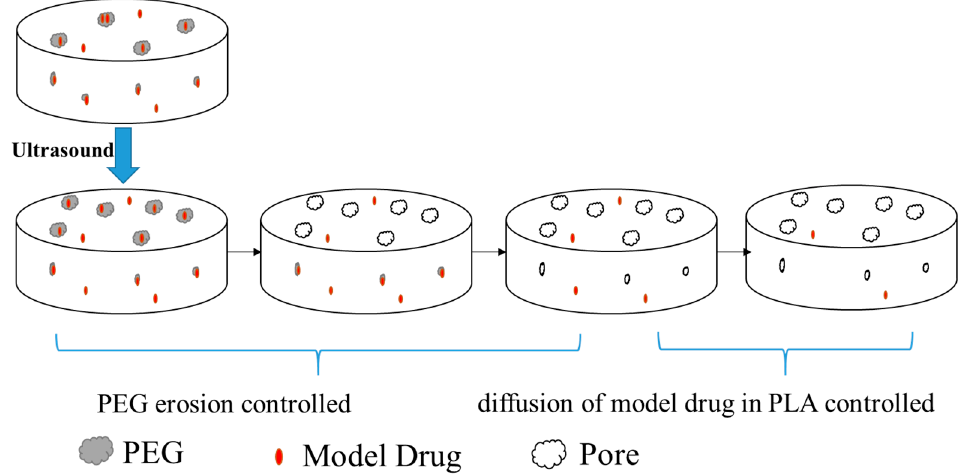
Figure 7. Scheme of the effect of ultrasound on the release of model drug MB from the PLA/PEG blends.